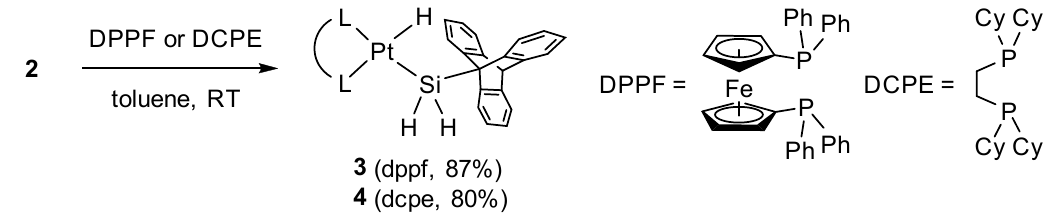
Figure 2. ORTEP of [PtH(SiH 2 Trip)(dppf)] 3 50% thermal ellipsoids, a solvation CH 2 Cl 2 molecule, and hydrogen atoms, except H1, H2, and H3 were omitted for clarity. Selected bond lengths (Å) and bond